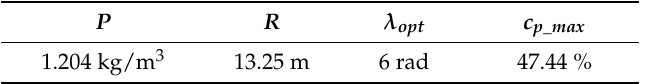
Table 2. Parameters of the wind turbine for the gain of the turbine k t .